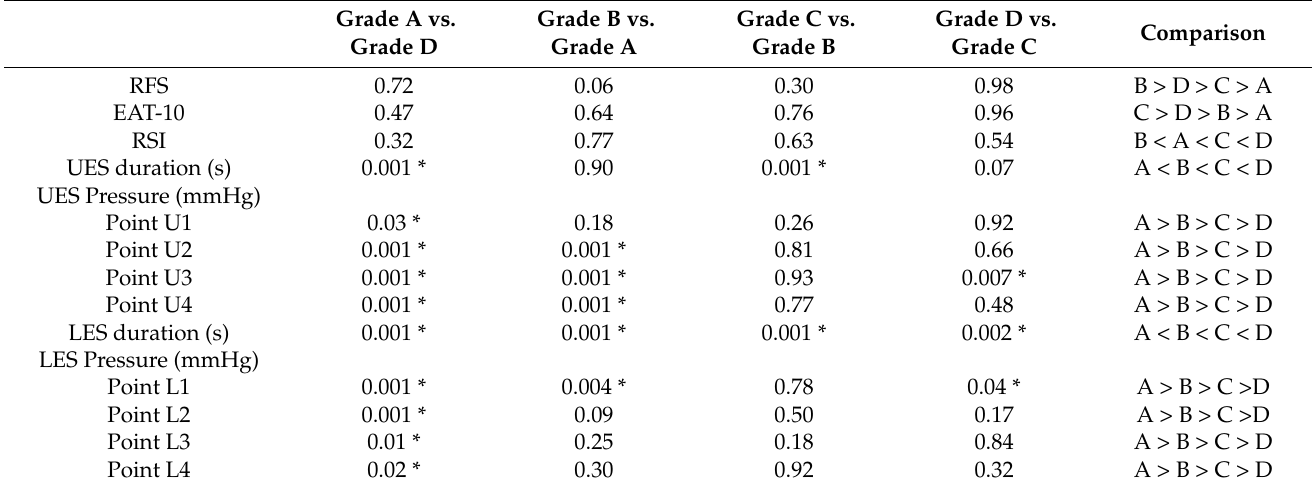
Table 3. Summary of p -values of post hoc test in assessment values between the two grade of